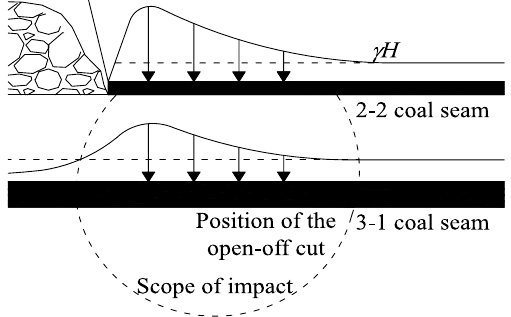
Figure 10. Distribution of lateral support pressure in the open-off cut.